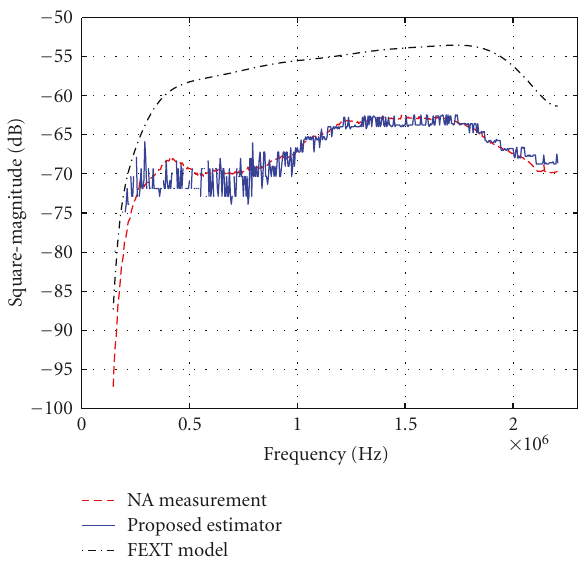
Figure 15: Square-magnitude of the upper (longer) FEXT channel for access network scenario III obtained with the NA, the FEXT model, and the proposed estimator.